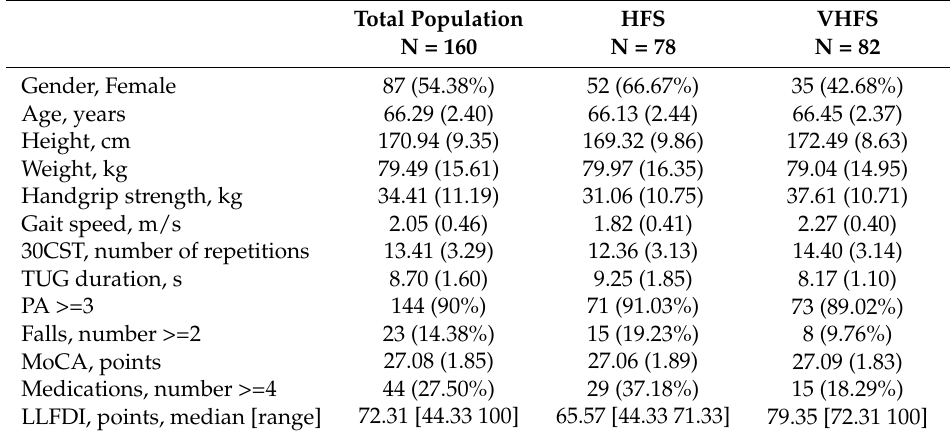
Table 3. Description of the population stratified by High Functional Status (HFS) and Very High Functional Status